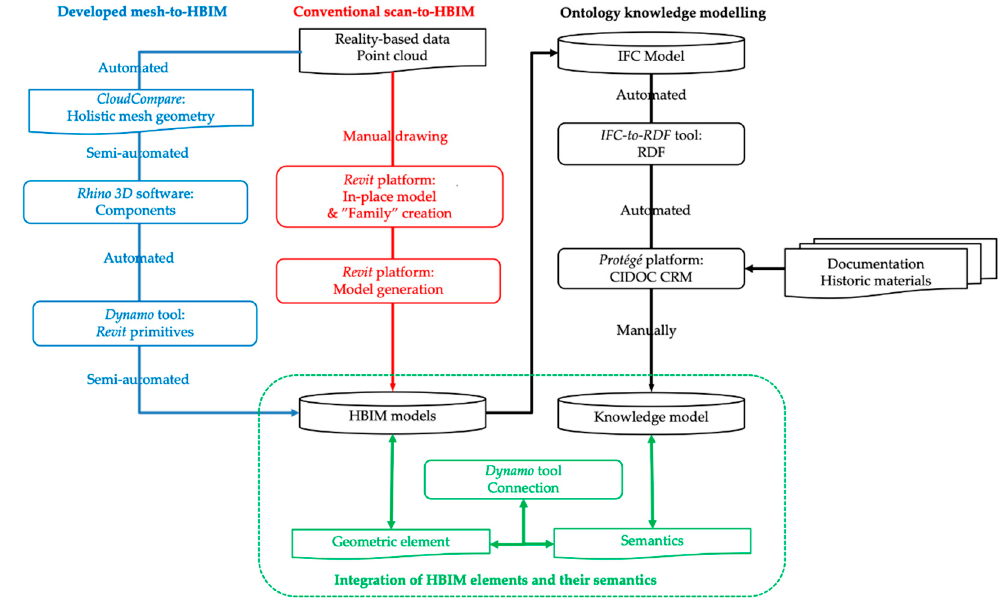
Figure 1. Workflows of the HBIM modeling and the integration with ontological knowledge.